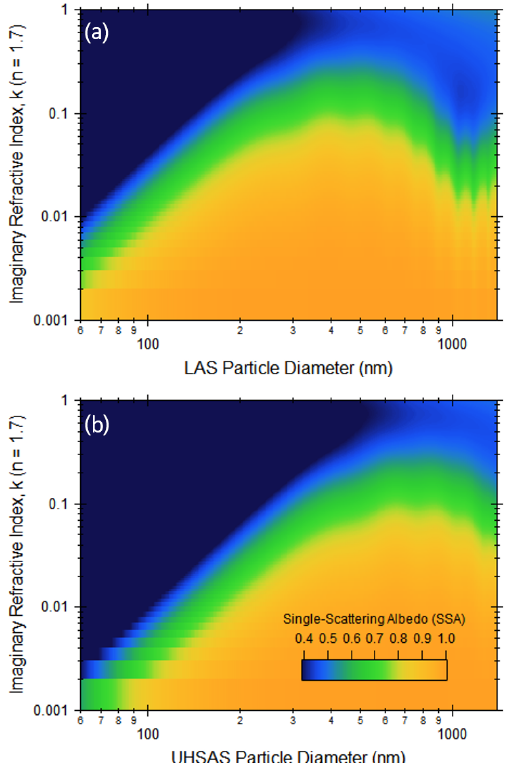
Figure 2. Mie theory calculations of size-resolved particle single- scattering albedo for varying imaginary refractive indices at the LAS laser wavelength of 633nm (a) and the UHSAS laser wave- length of 1054nm (b) . The real part of the refractive is held constant at 1.7. Unlike Fig. 1, these SSA values are computed from the to- tal aerosol scattering and extinction coefficients that are integrated across all angles of the phase function. Figure 3. SEMS DMA sizing verification with NIST-traceable